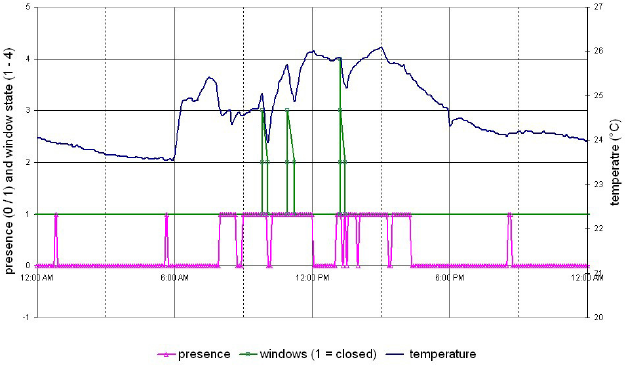
Fig. 7. Result of monitoring for one office (presence, windows and temperature).